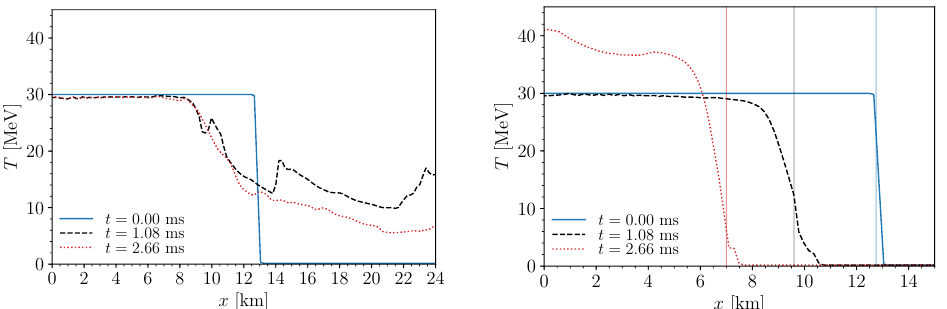
Figure 3. Evolution of the temperature profile inside the star along the coordinate x direction at the innermost level l = 2. Run A ( left panel): we present temperatures up to the level l = 2 boundary to show that in this case, within our simulations timespan, the NS has increased radius with respect to t = 0. We note that at t = 1.08 ms and t = 2.66 ms, the NS is still expanding and ejecting material. Run A- ν ( right panel): the vertical lines mark the position of the electron neutrino neutrinosphere. In general, outside the neutrinosphere, the material has lower temperatures and the cooling becomes less effective towards the core due to the dominance of diffusive processes. By the end of the first expansion cycle ( ∼ t = 1.08 ms), the internal temperatures are nearly unchanged, whereas a large portion outside the neutrinosphere is cooler. Likewise, on the verge of the gravitational collapse ( t = 2.66 ms), the layers outside of the neutrinosphere are cold, while the interior is hotter due to